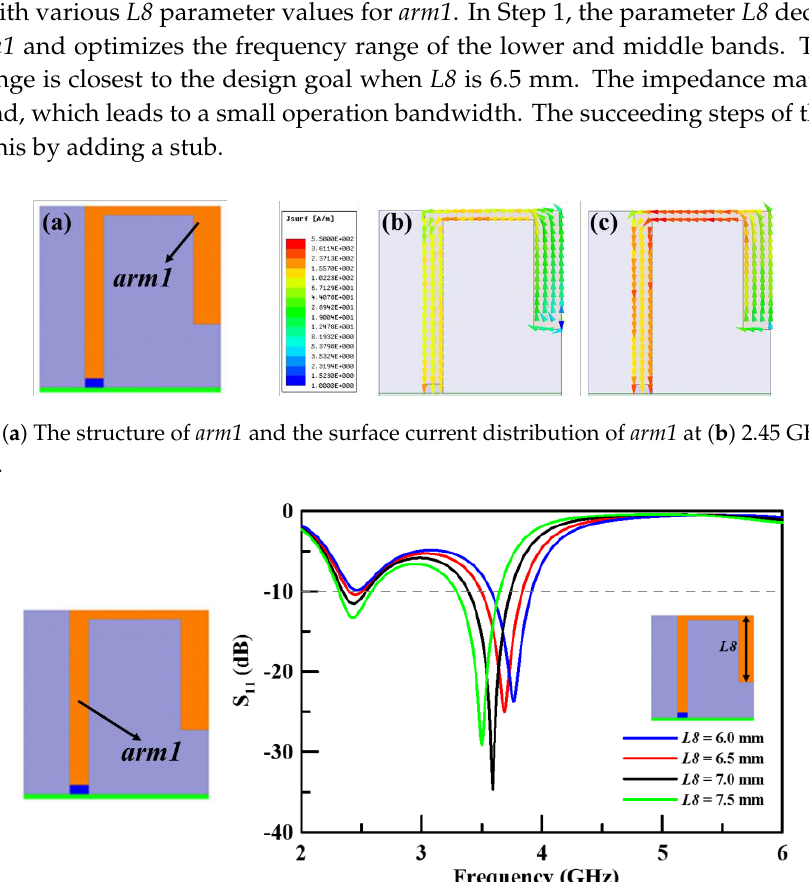
Figure 5. The simulated return loss with various lengths of W7 (Step 2).